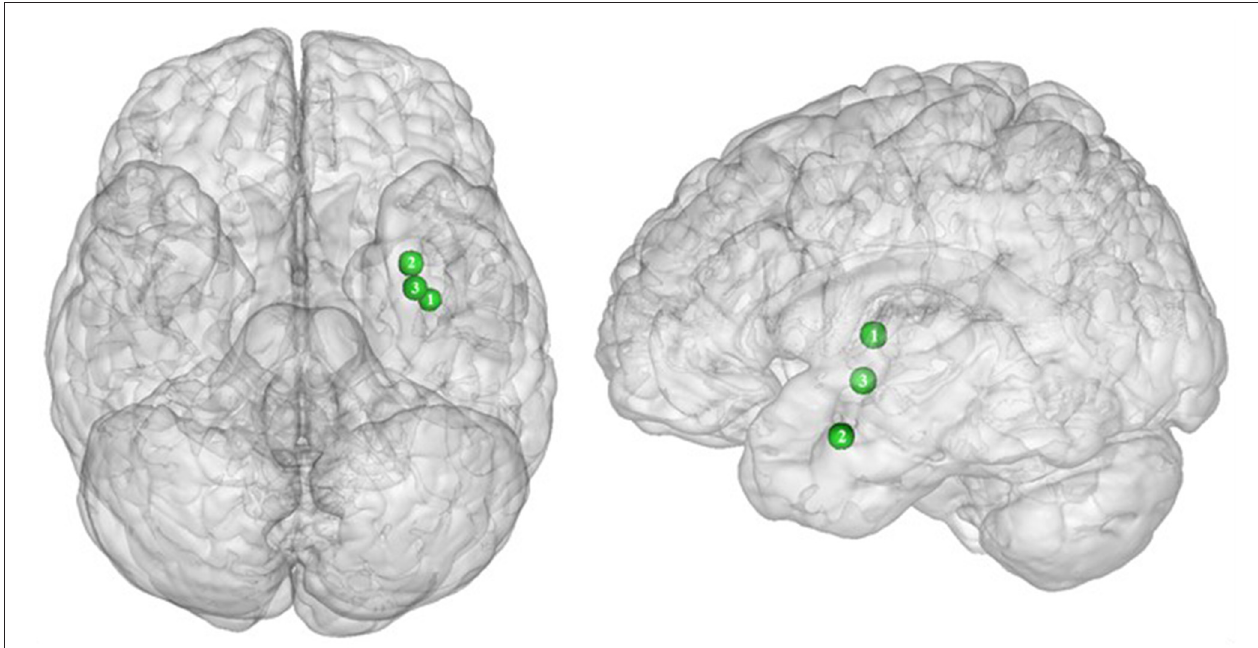
FIGURE 5 | Inverted U-shaped pattern of functional activity during inhibition. Green color indicates an increased neural activity in class-I obese (BMI = 30) in comparison with lean participants, and an attenuated activity in obesity classes II and III (BMI = 35–40) reaching similar patterns of activation as in lean participants (see Table 5 for precise coordinates). 1 = insula ( 32), 2 = claustrum (32), 3 = Putamen